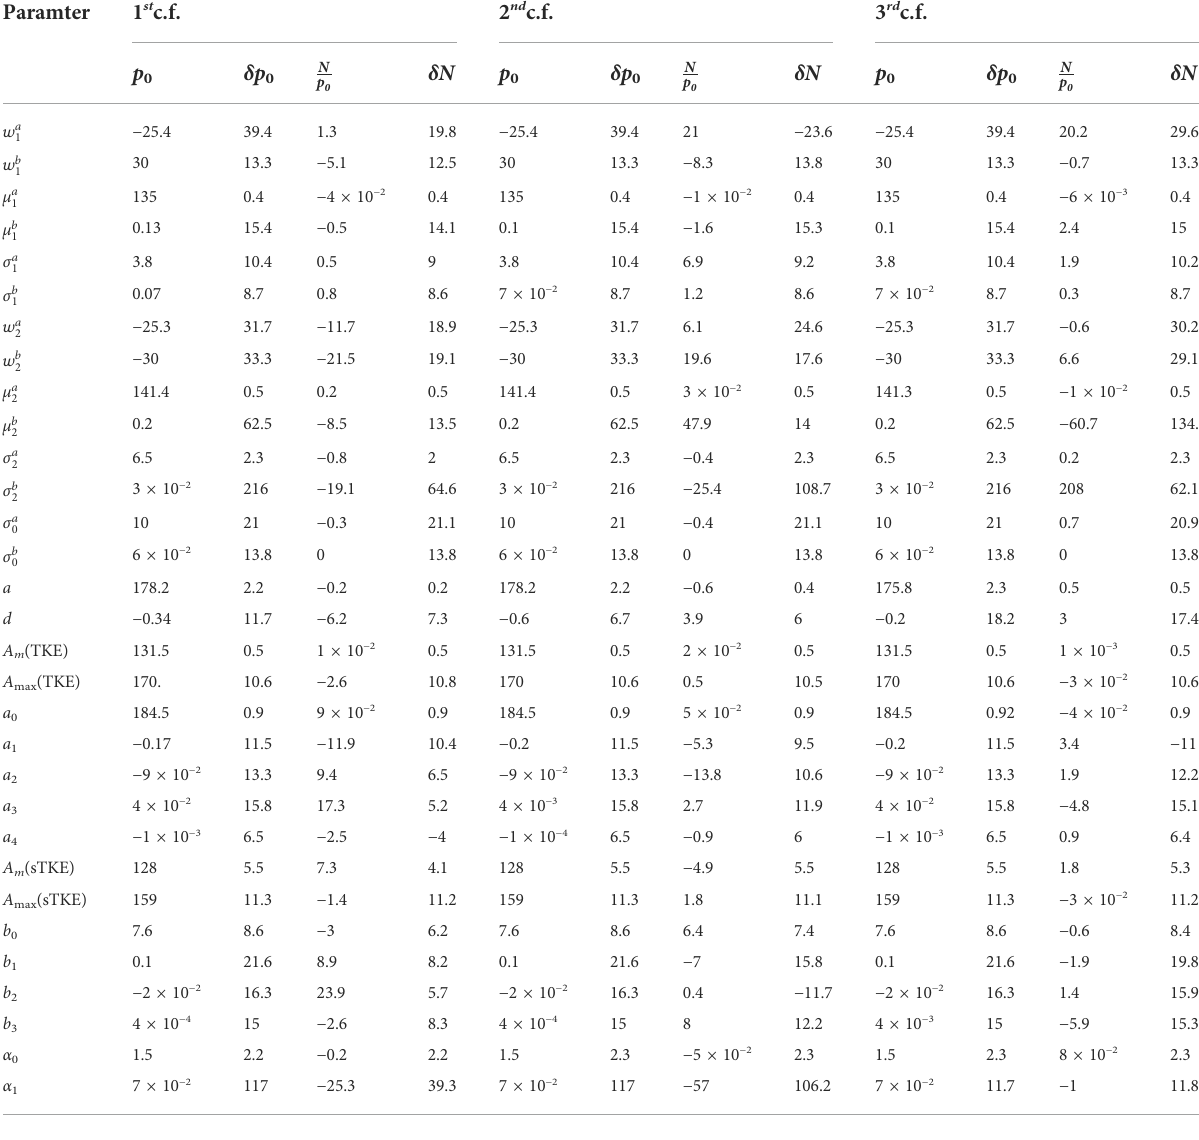
TABLE 2 Prior CGMF parameter values, p 0 , for the (cid:1) ] p evaluation are given along with their uncertainties in %, δ p 0 . The variable N signi fi es one of the evaluated parameters. The change in evaluated parameters as a ratio to the prior, N